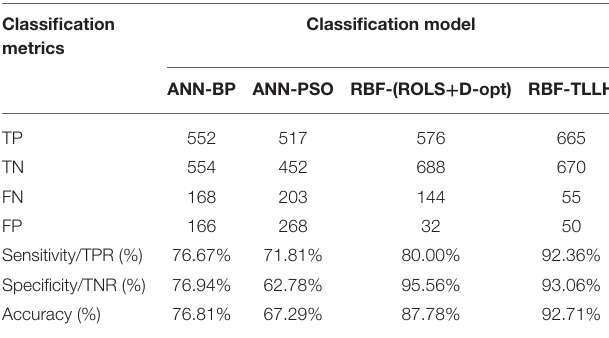
TABLE 2 | Classification results of fatigue state vs . alert state for the validation set. Classification